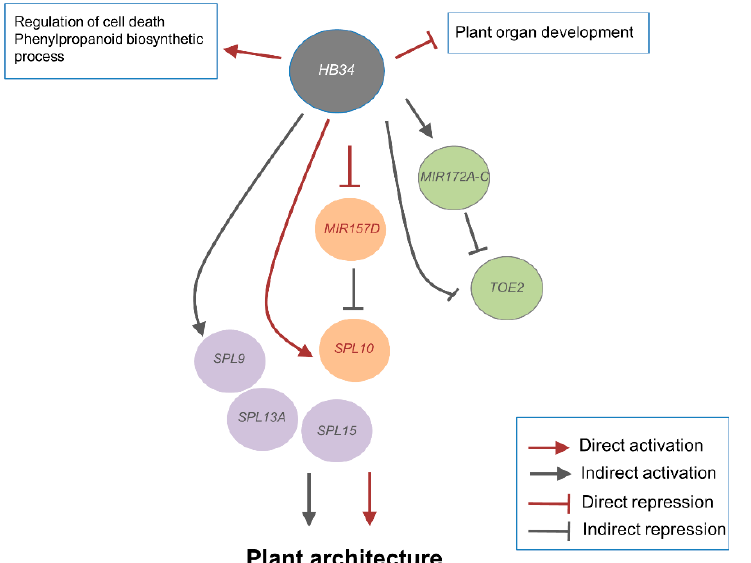
Figure 6. Proposed model of regulation mediated by HB34 and miR157. HB34 binds and represses MIR157D to activate SPL10 , generating an FFL, and indirectly regulates the SBP gene family ( SPL9, SPL13A , and SPL15 ). HB34 also indirectly activates MIR172A–C , which are involved in the FFL with TOE2 , a target of miRNA172. Based on the expression profile and mutant phenotype analysis, HB34 is involved in various developmental processes: it is a negative regulator of plant organ development and a positive regulator of cell death and phenylpropanoid biosynthesis.